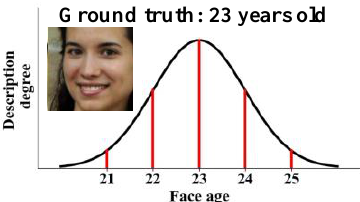
Figure 1. Gaussian-based label distribution of an age image. The face image comes from the dataset of Chalearn 2015 [7].